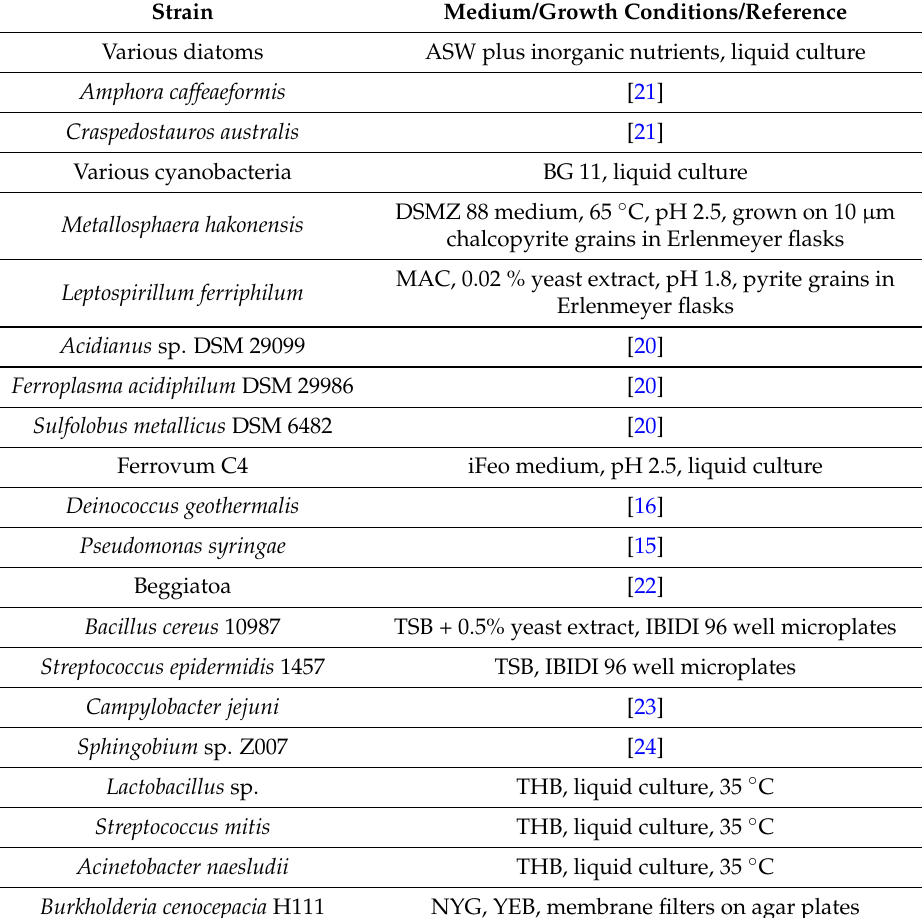
Table 1. Strains examined by fluorescence lectin bar-coding